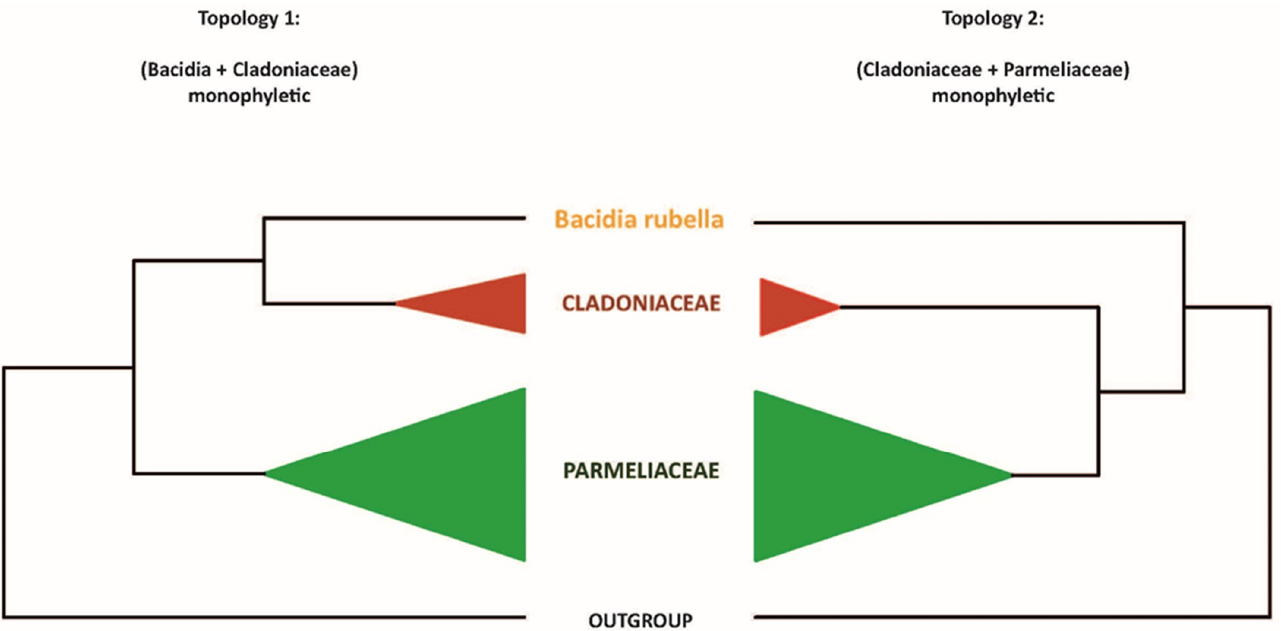
Figure 1. Two alternative topologies used for comparison in the topology test. Topology 1, recover- ing Bacidia + Cladoniaceae as monophyletic; Topology 2, recovering Cladoniaceae + Parmeliaceae as monophyletic.